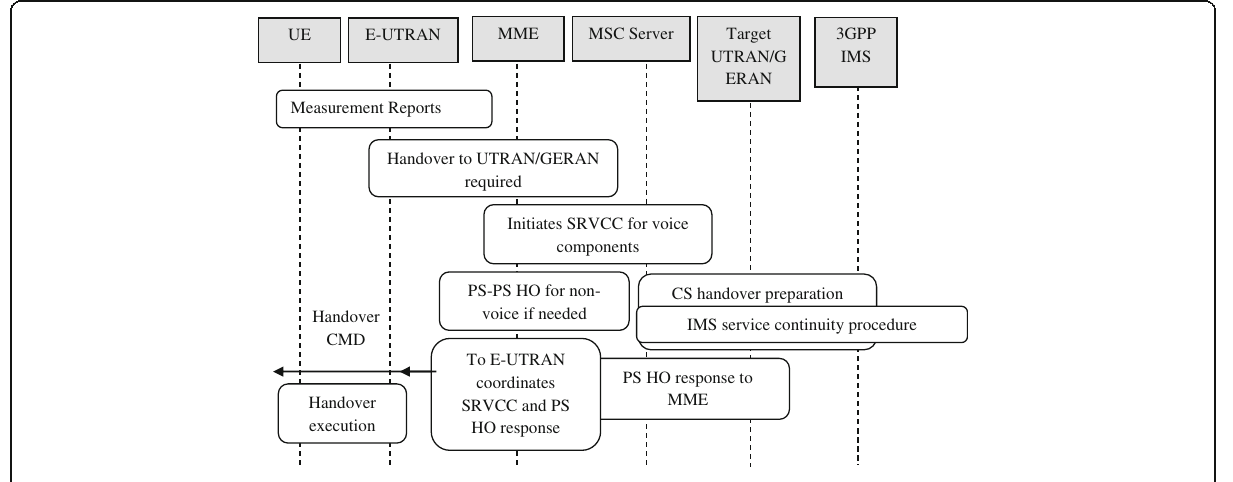
Fig. 2 SRVCC procedure from E-UTRAN to